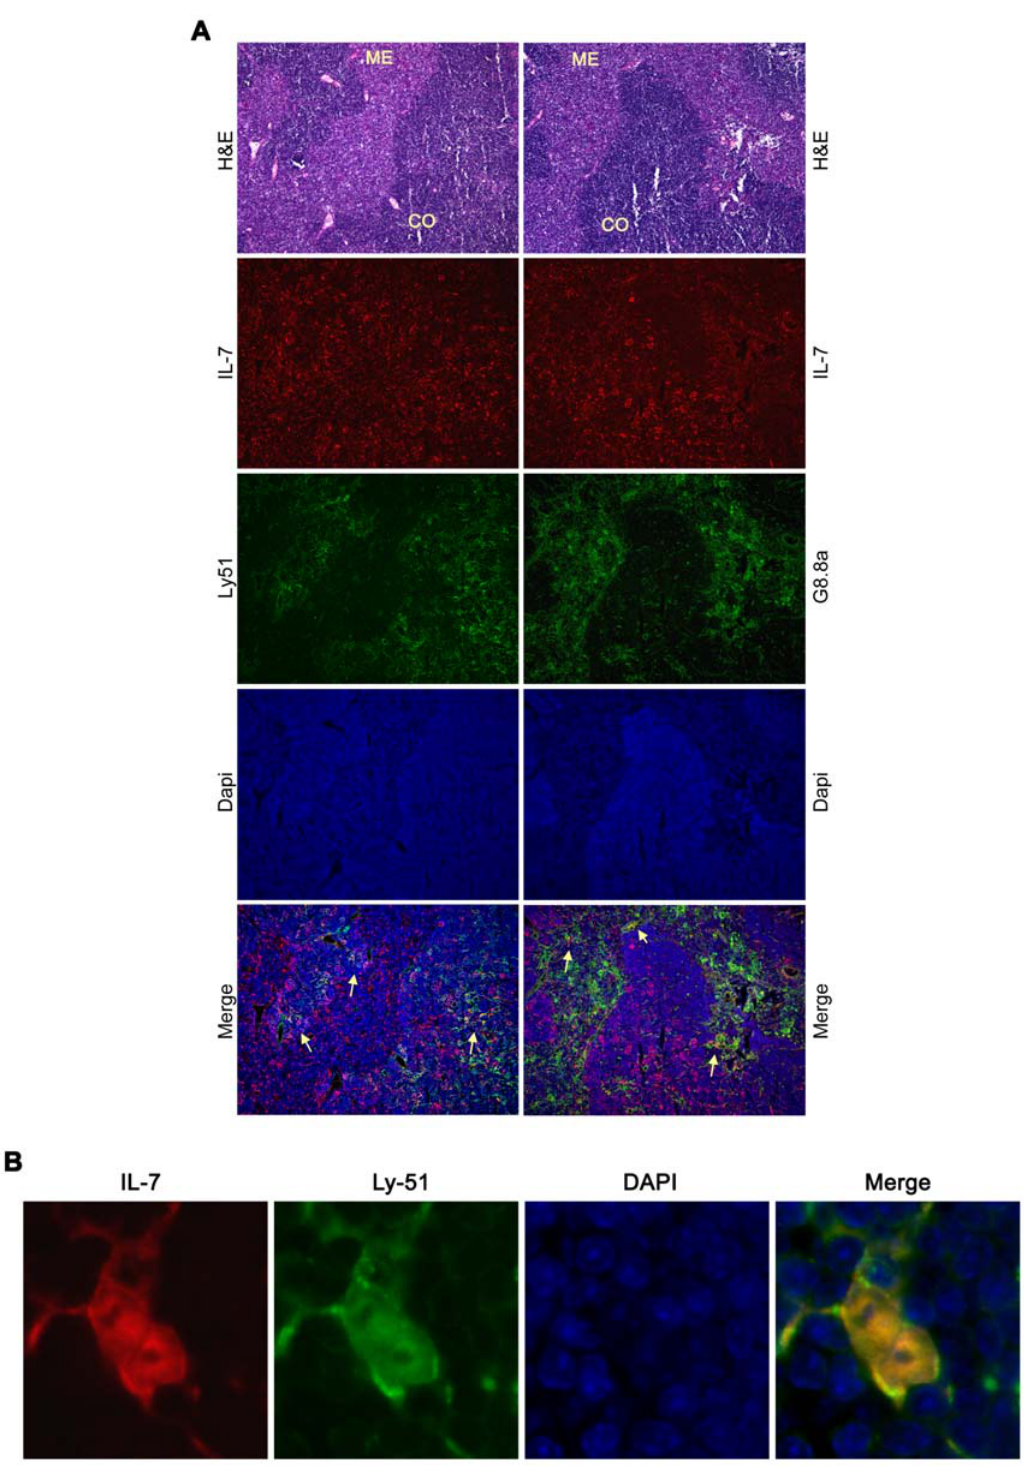
Figure 3. Cortical and medullary epithelial cells express IL-7 in thymus. A. Colocalization of ECFP-positive cells (red staining) with Ly51 and G8.8a (green staining) indicates the cortical cells and medullary epithelial cells, respectively, are responsible for production of IL-7 in thymus. H&E staining shows thymocyte distribution between cortex and medulla. Single color staining show the expression of ECFP (counterstained red), cortical Ly51 positive cells or medullary G8.8a positive cells (green), nuclei visualization by DAPI (blue). In the merged figures, the arrows indicate some cells with co-localization of red and green (yellow staining). Magnification 100 6 . B. Detail of the body of two cortical epithelial cells (magnification 400 6 ). The yellow staining in the merged figure visualized the co-localization between ECFP (counterstained red) and the cortical marker Ly51 (green).